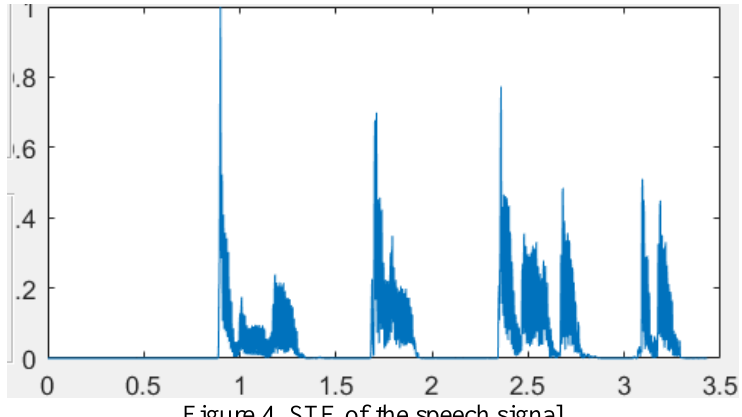
Figure 4. STE of the speech signal